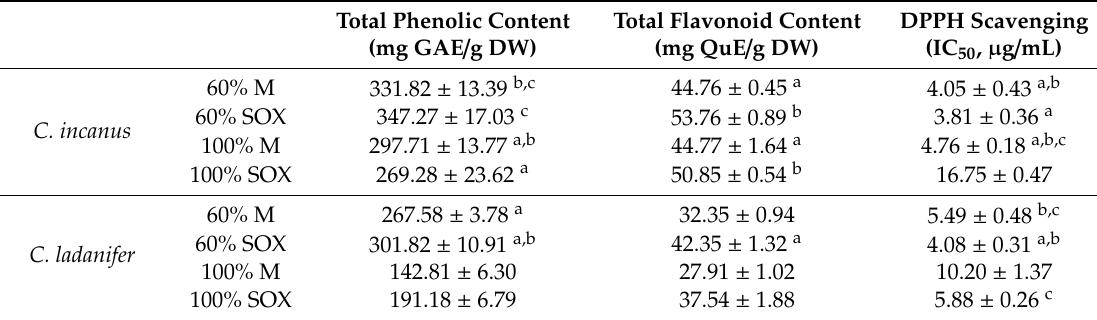
Table 2. The content of total phenolics, flavonoids and DPPH scavenging activity in C. incanus and C. ladanifer